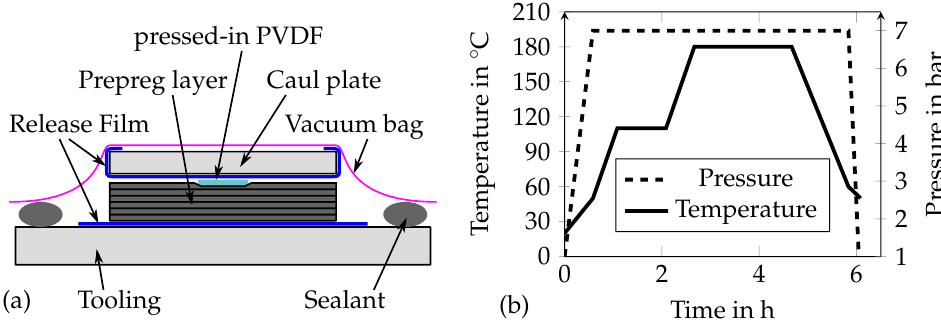
Figure 7. Setup for co-curing the PVDF inlays Figure 8. Co-curing autoclave process Figure 6. ( a ) Setup for co-curing the inlays to the CFRP adherends. ( b ) Co-curing autoclave process.